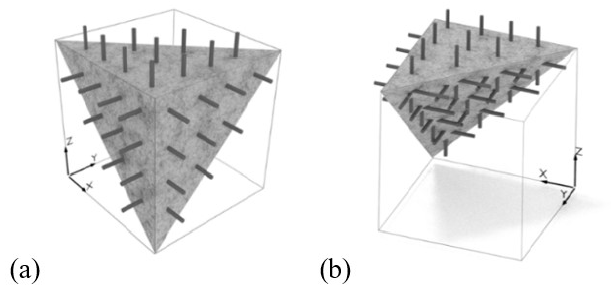
Figure 7. Cracked solid element with reinforcement in three orthogonal directions: (a) side view; (b) view of the inclined crack plane crossed by the